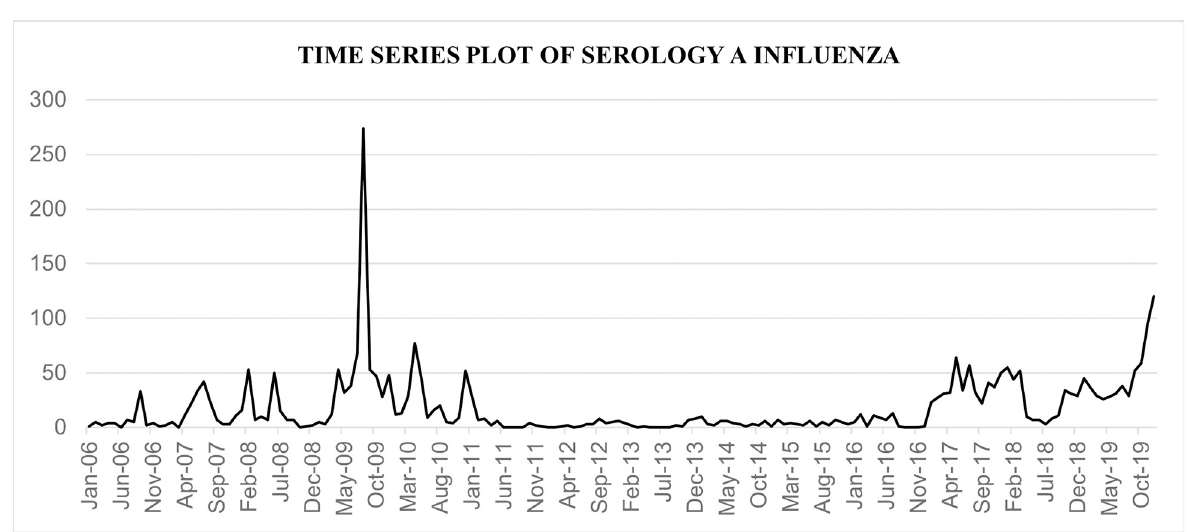
Fig 2. A time series plot for the number of influenza cases in Malaysia from January 2006 until December 2019.